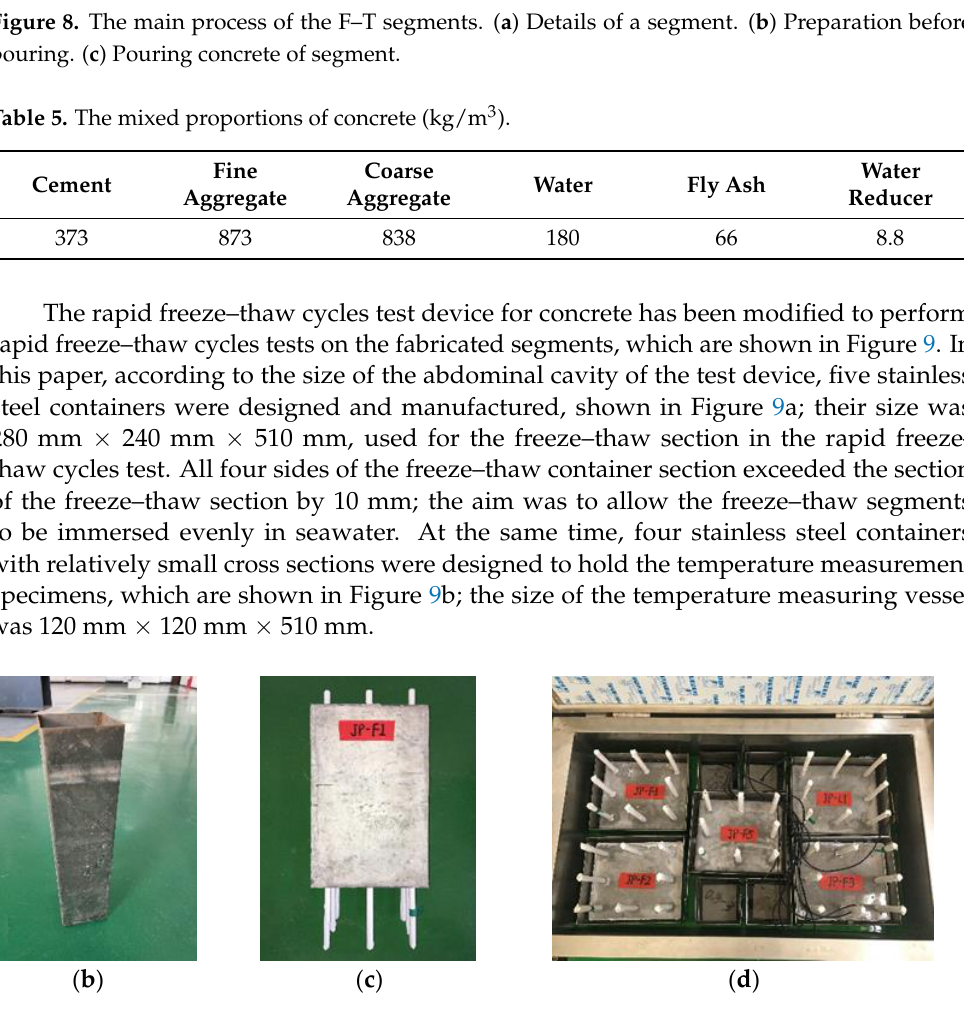
Figure 9. Rapid freeze – thaw cycles test for the F – T segments. ( a ) Freeze – thaw cycles container. ( b ) Constant temperature container. ( c ) Rust prevention. ( d ) Inside the testing machine.